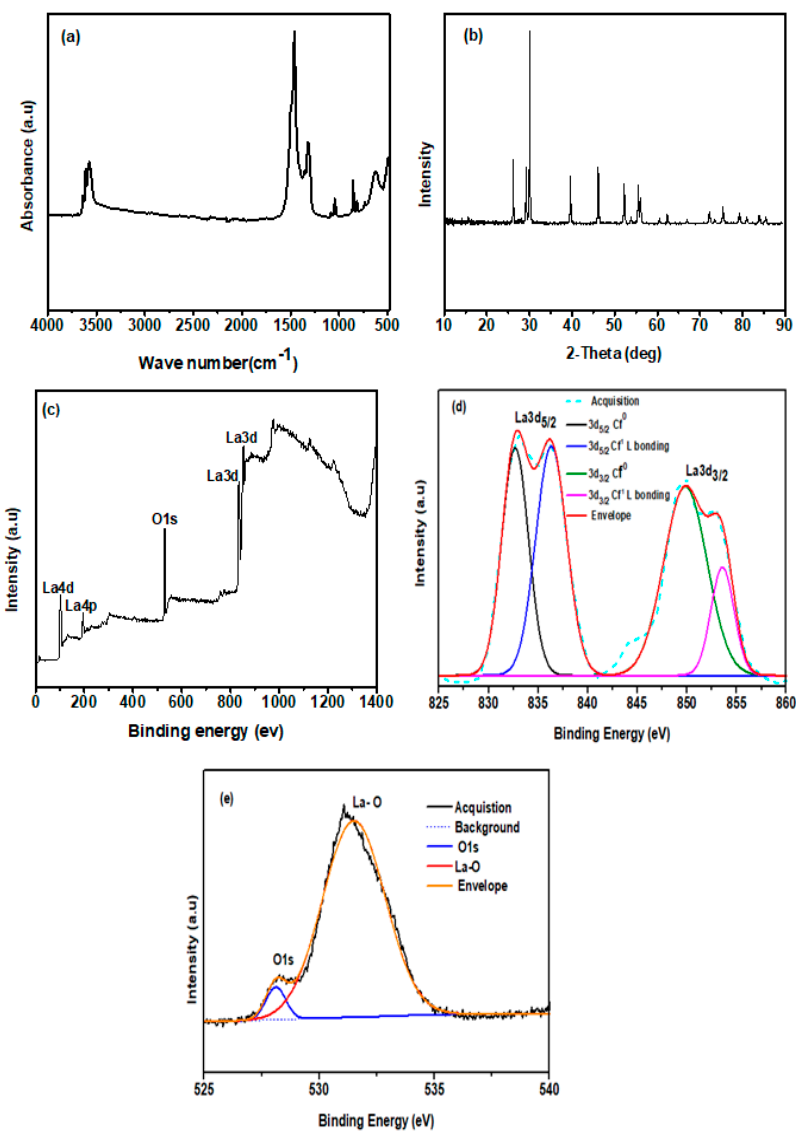
Figure 1. Spectroscopic characterization: ( a ) FT-IR spectra, ( b ) XRD patterns, and ( c ) XPS patterns of La 2 O 3 nanorods, and ( d ) high-resolution XPS of La 3d and ( e ) O 1s of prepared La 2 O 3 .